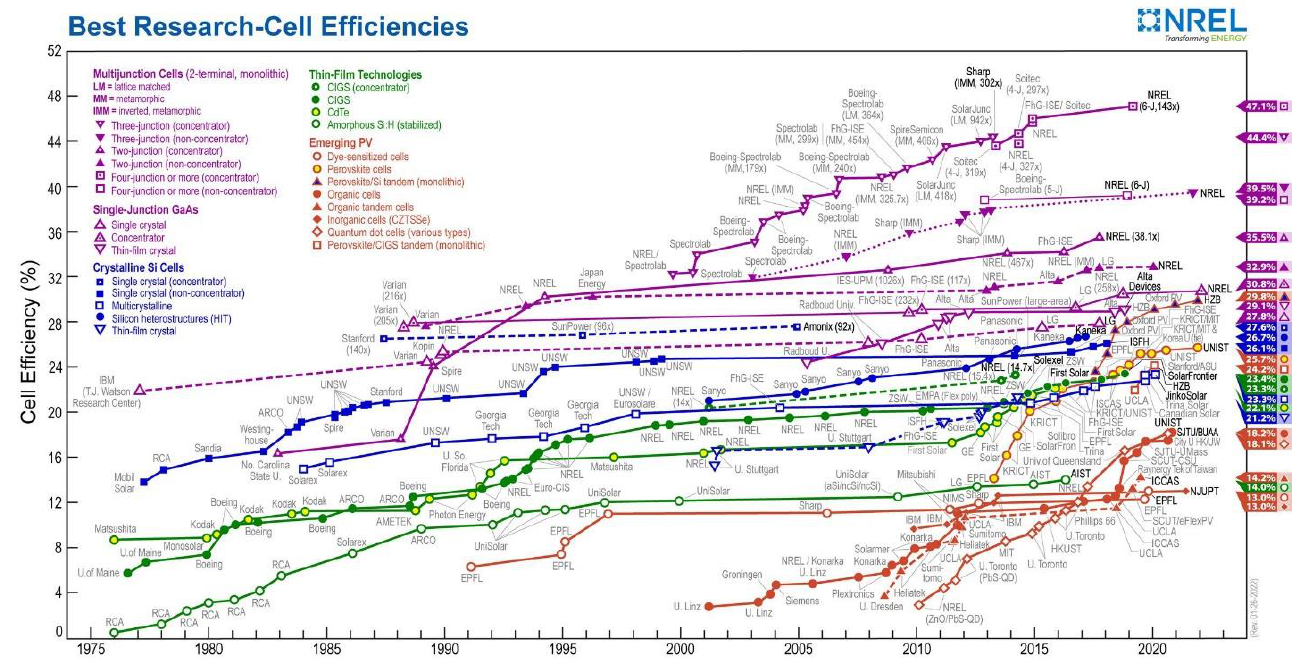
Figure 2. Development of solar cell efficiency based on various technologies. Source: [56].